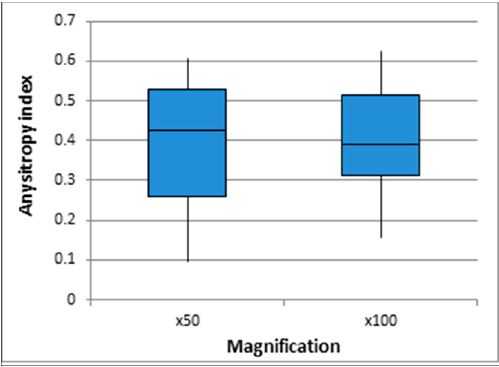
Figure 6. Anisotropy index estimated for SEM micrographs captured with ×50 and ×100 magnifica- tion.